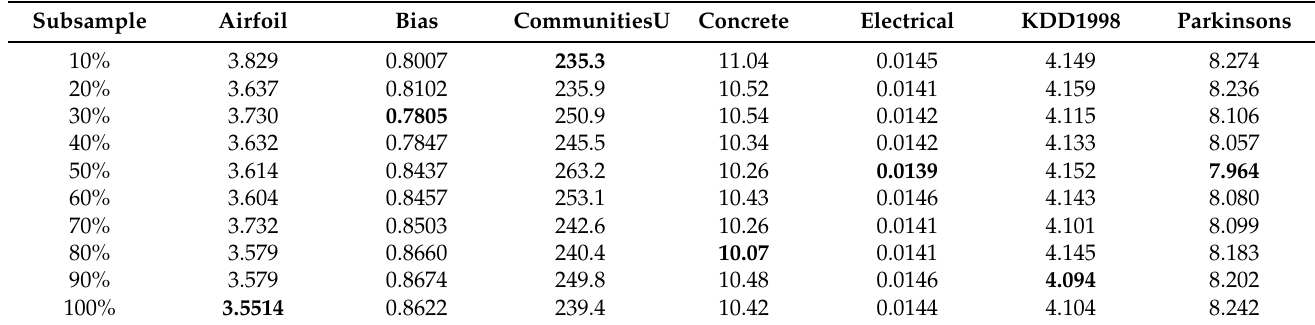
Table 3. ADABOC MAE results by subsample parameter value.